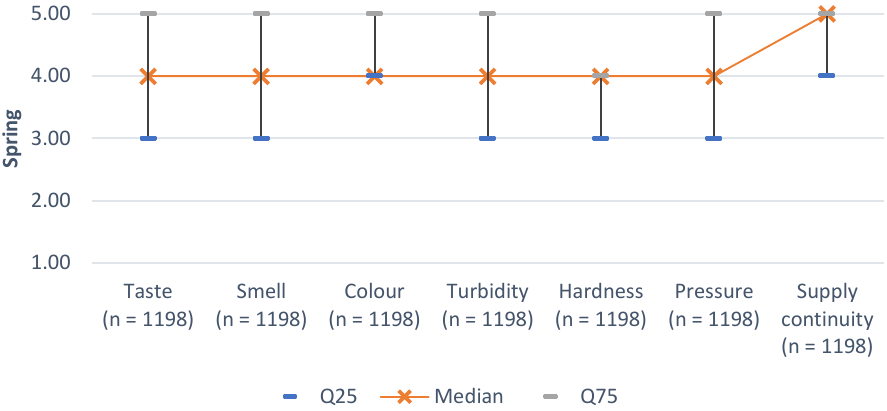
Figure 2. Respondents’ evaluation of individual tap water parameters during the spring period. In the summer period, statistically significant differences in the ratings of individual tap water parameters were also noted, as shown by analysis with the Kruskal-Wallis test: H(6, N = 8386) = 651.92; p < 0.001; E R2 = 0.08. The post hoc test showed that, as in the case of the spring period, there were statistically significant (p < 0.001) differences between the ratings for continuity of water supply (higher rating) and all other parameters (lower rating) and statistically significant (p < 0.01 or p < 0.001) differences between the ratings for water hardness (lower rating) and all other parameters (higher rating). The ratings for colour and turbidity were also statistically significantly (p < 0.001) different (higher rating) from its taste and pressure (lower rating); in addition, there were statistically significant (p < 0.001) differences between the ratings for colour (higher rating) and odour (lower rating). The above differences are confirmed by the results of descriptive statistics on the ratings of individual parameters during the summer. The best and worst rated parameters were continuity of supply and hardness, respectively (M Continuity of supply = 4.48; SD Continuity of supply = 0.81 and M Hardness = 3.52; SD Hardness = 1.15). Water colour was the second most highly rated parameter (M = 4.01; SD = 1.07), but water turbidity was slightly worse (M = 3.94; SD = 1.08). Taste and odour had slightly worse ratings in the summer period (M Taste = 3.8; SD Taste = 1.03 and M Smell = 3.85; SD Smell = 1.04), while pressure — apart from water hardness — was the worst rated (M = 3.68; SD = 1.19) (Figure 3). The evaluation of individual parameters in relation to the autumn period also varied in a statistically significant way, as shown by analysis with the Kruskal-Wallis test: H(6, N = 8386) = 719.3; p < 0.001; E R2 = 0.09. The post hoc test in turn showed that, as in the spring and summer, there were statistically significant (p < 0.001) differences between the ratings for continuity of water supply (higher rating) and all other parameters (lower rat- ing) and statistically significant (p < 0.001) differences between the ratings for water hard- ness (lower rating) and all other parameters (higher rating). There were also statistically significant (p < 0.001) differences between the ratings for colour, turbidity, and water pres- sure (higher rating) and the ratings for taste (lower rating). In addition, there were statis- tically significant (p < 0.001 or p < 0.05) differences between the ratings for colour and pressure (higher rating) and the ratings for smell (lower rating). The results of descriptive statistics on the ratings of individual parameters during the autumn period indicate that continuity of supply was rated highest (M = 4.54; SD = 0.78), while water hardness was rated lowest (M = 3.52; SD = 1.15). The ratings for colour, pressure, and turbidity were similar, with colour being the best rated among these three parameters (M Colour = 4.01; SD Colour = 1.07; M Turbidity = 3.94; SD Turbidity = 1.07 and M Pressure = 3.96; SD Pressure = 1.11). The smell of the water was rated slightly worse in autumn (M = 3.85; SD = 1.05), and the taste of the water was rated worst, apart from the aforementioned water hardness (M = 3.78; SD = 1.04) (Figure 4).